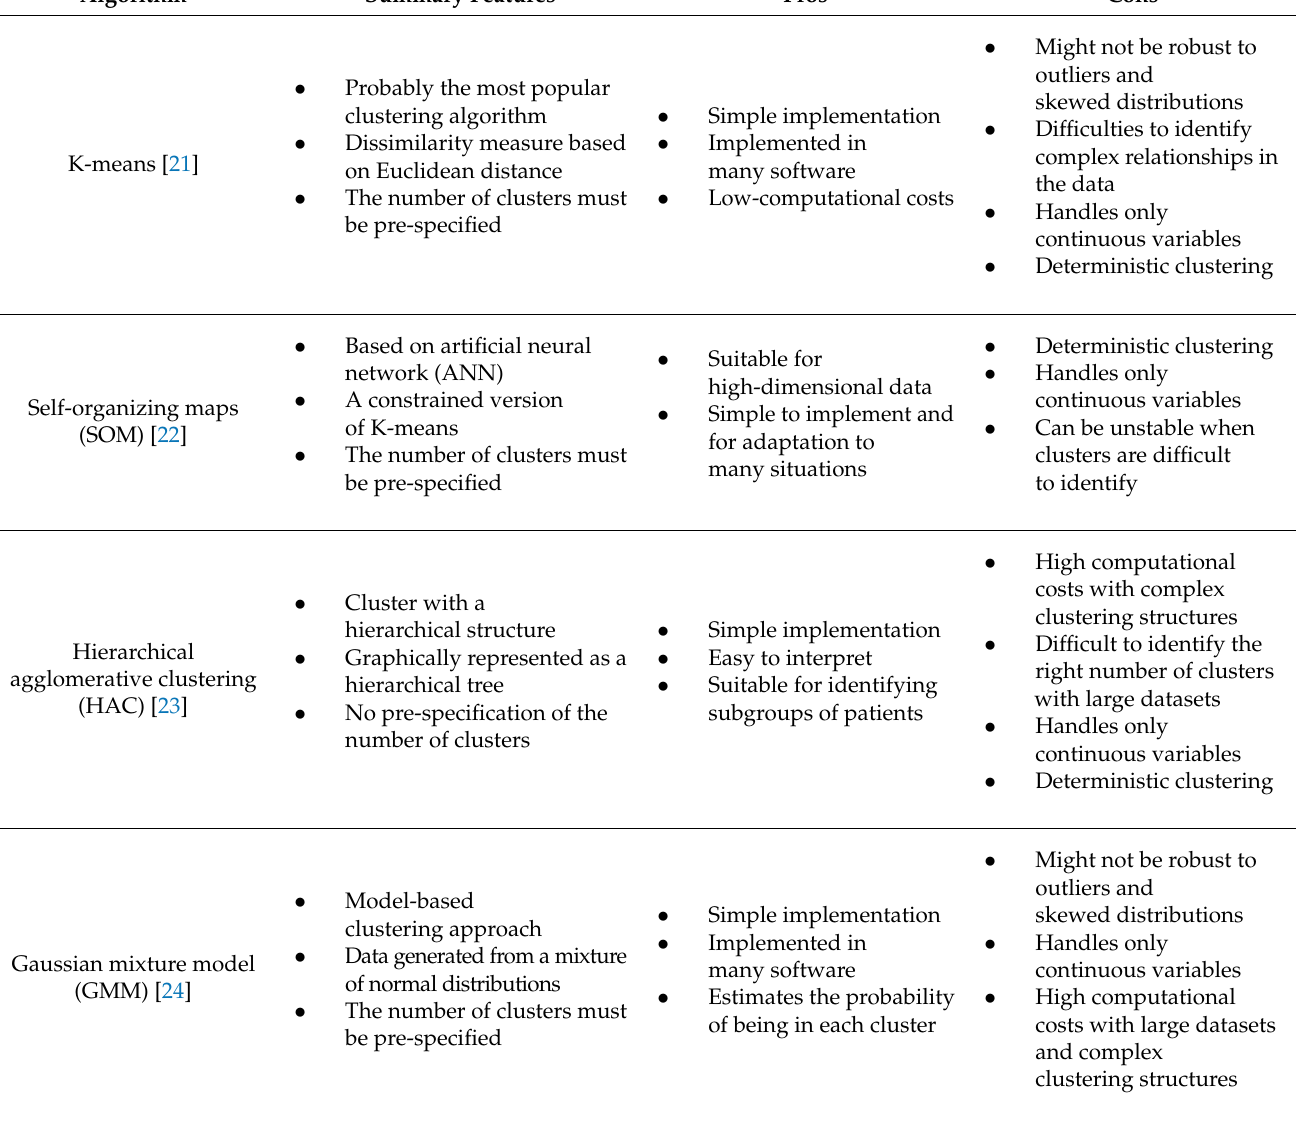
Table 1. Summary of the main characteristics of the algorithms, along with their pros and